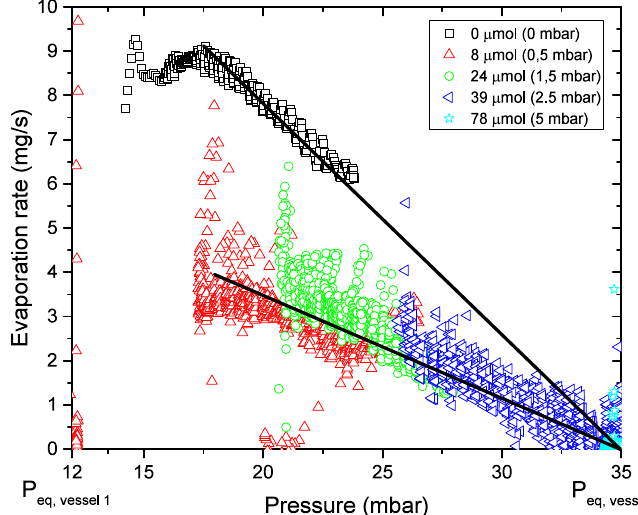
Figure 12. The evaporation rate from vessel 2 plotted against the pressure measured in the system. All experiments with some initial NCG are overlapping, the one without initial NCG in the system has a way higher evaporation